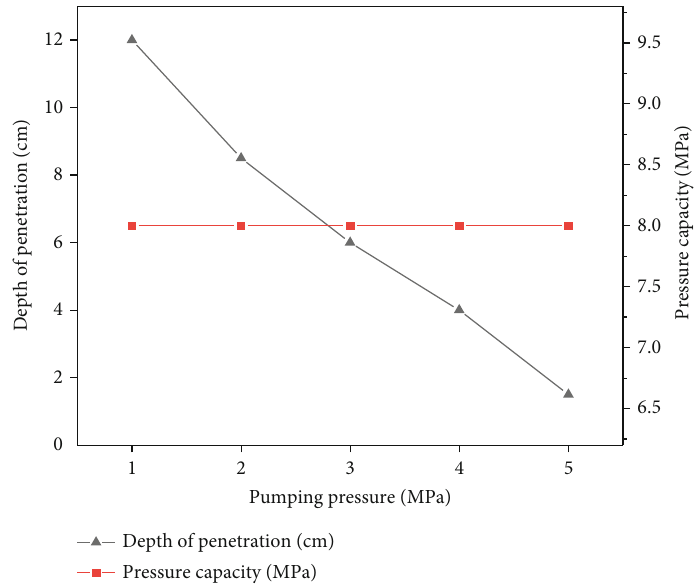
Depth of penetration (cm) Figure 6: The e ff ect of pumping pressure on the pressure-bearing capacity and invasion depth of the plugging